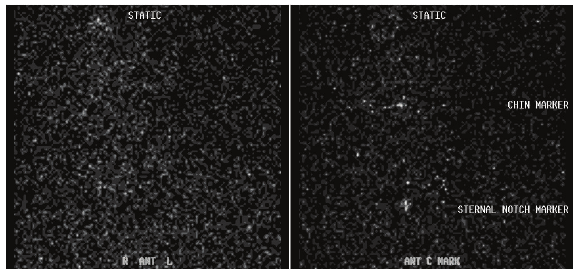
Figure 2: Radioiodine uptake and scan using 143 𝜇 Ci of I-123 showing 0.6% uptake at 4 hours (no activity within the thyroid